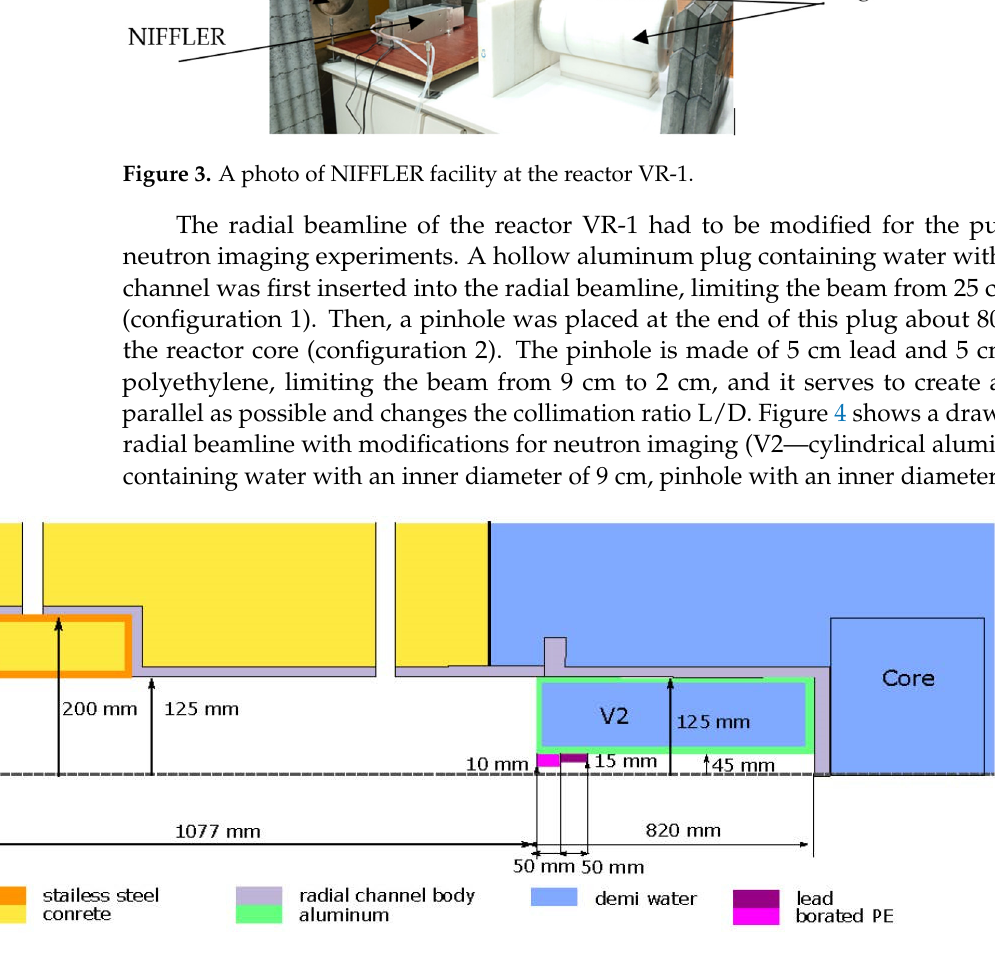
Figure 3. A photo of NIFFLER facility at the reactor VR-1.